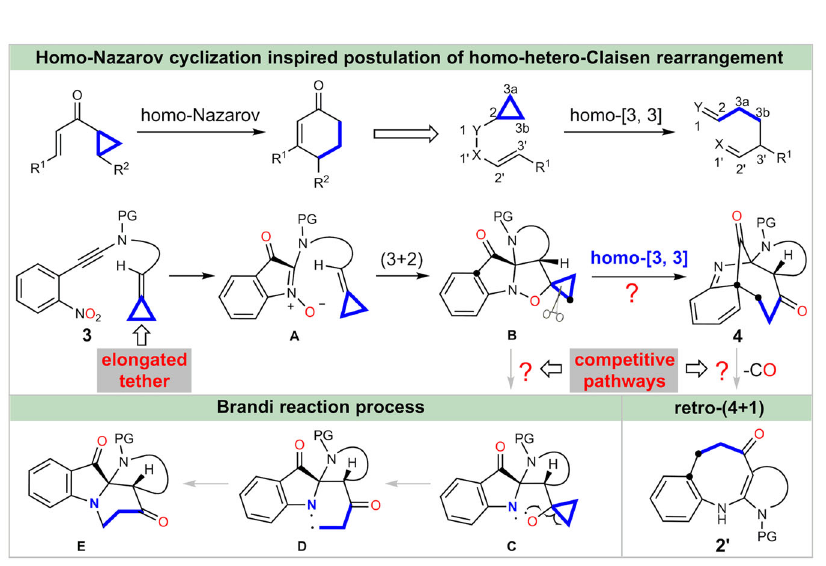
Fig. 4 | Minimization of ring strain in achieving bridged polyclcloalkanone. The homo-hetero-Claisen rearrangement postulation inspired by mechanistic insight of Claisen rearrangement and the homo-Nazarov cyclization. PG=protective group.